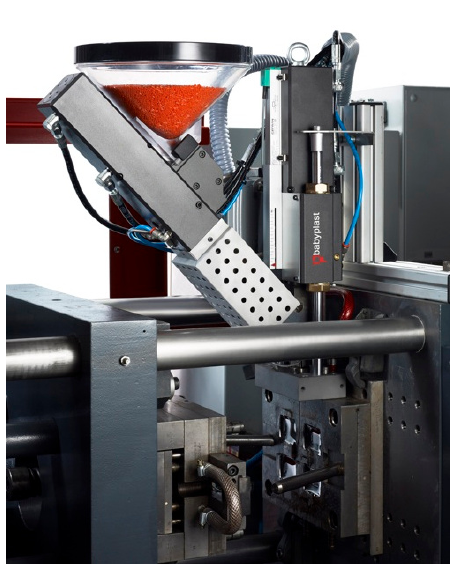
Figure 1. Extruder for